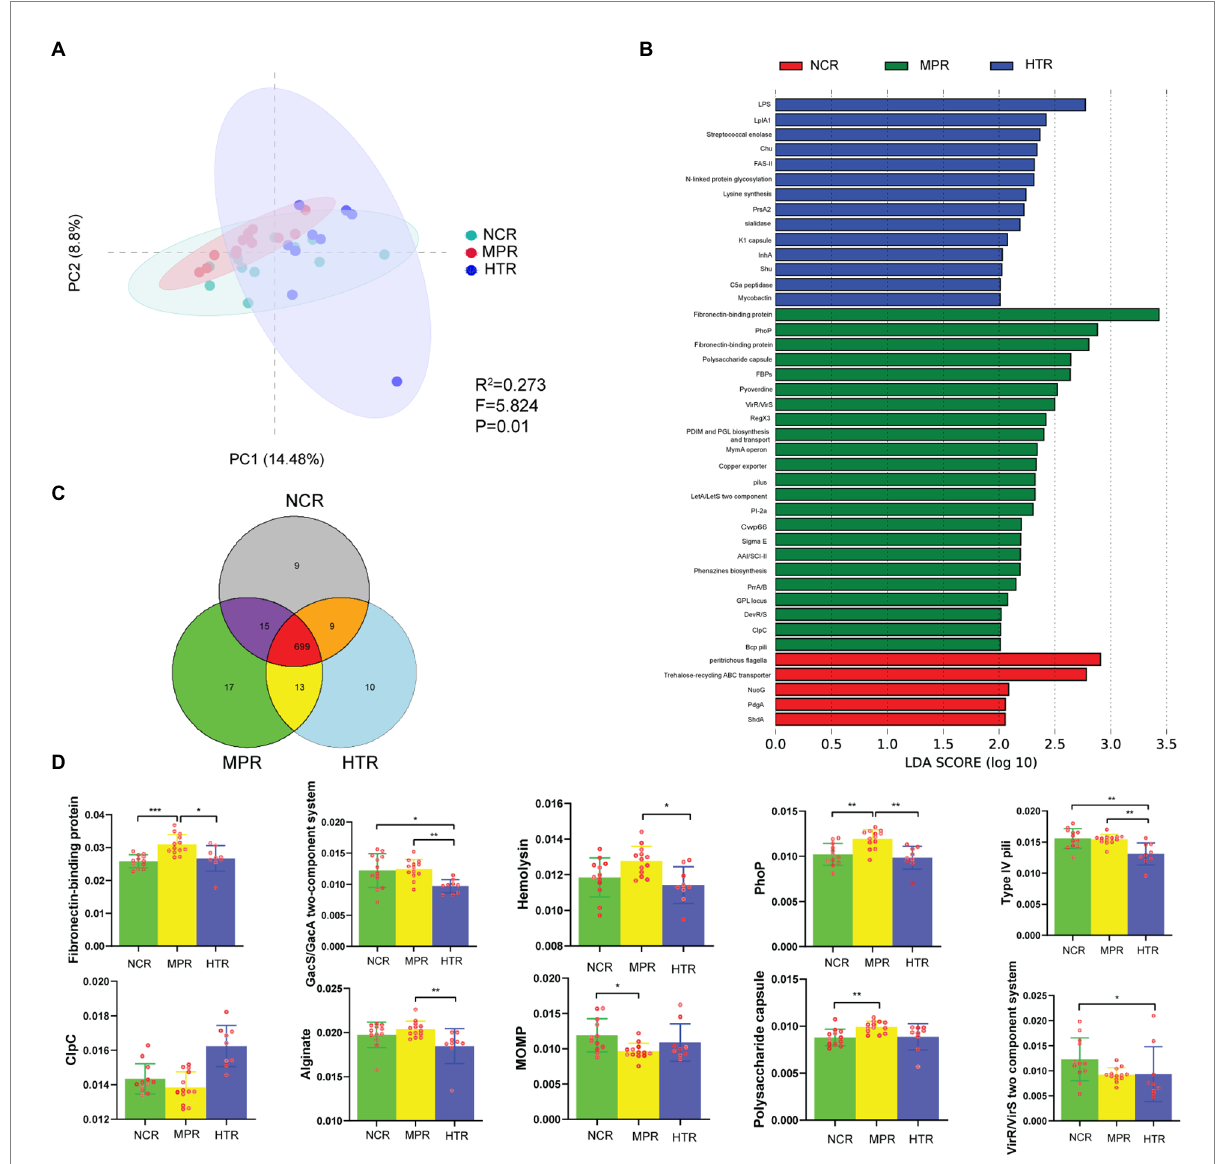
FIGURE 6 (A) PCoA plot based on the Bray–Curtis distance of VF relative abundance between the NCR, MPR, and HTR (Adonis, R 2 = 0.273, F = 5.824, p = 0.01). (B) The difference in VF abundance by LEfSe ( p < 0.05 and LDA > 2). (C) Distribution of VFs for the three study sites. (D) Relative abundance of VFs indicating significant discrepancies among the three study sites and top 25 samples, * p < 0.05; ** p < 0.01; *** p <